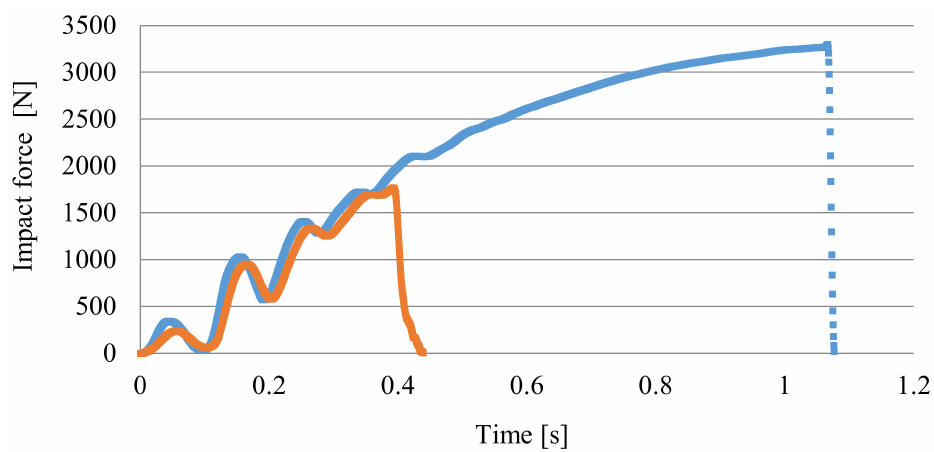
Figure 17. Courses the impact force and during the impact tests of PA66 GF30 unnotched (blue line) and notched (orange line) samples C with a thickness of 6 mm.